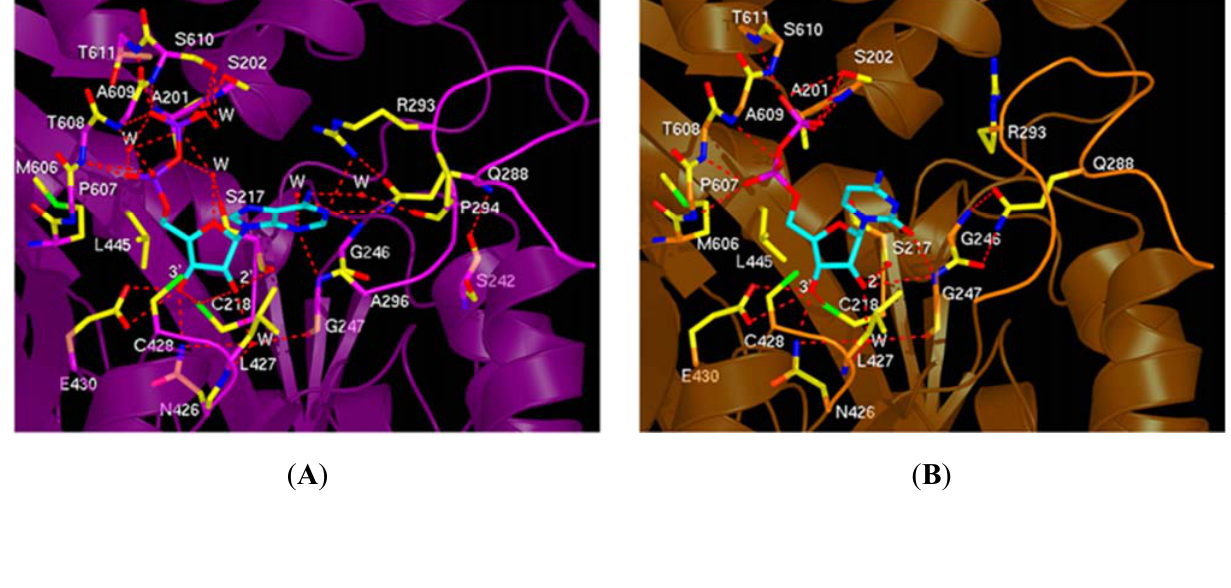
Figure 4. Substrate selection. ( A ) ADP binding at the C-site and ( B ) CDP binding at the C-site. The key residues on loop 2 required for substrate selection are Q288 and R293 are to the right. The catalytic residues C218, C428, N426 and E428 are also shown binding to the ribose moiety. Reproduced with permission from PNAS [13]. Copyright (2006) National Academy of Sciences,